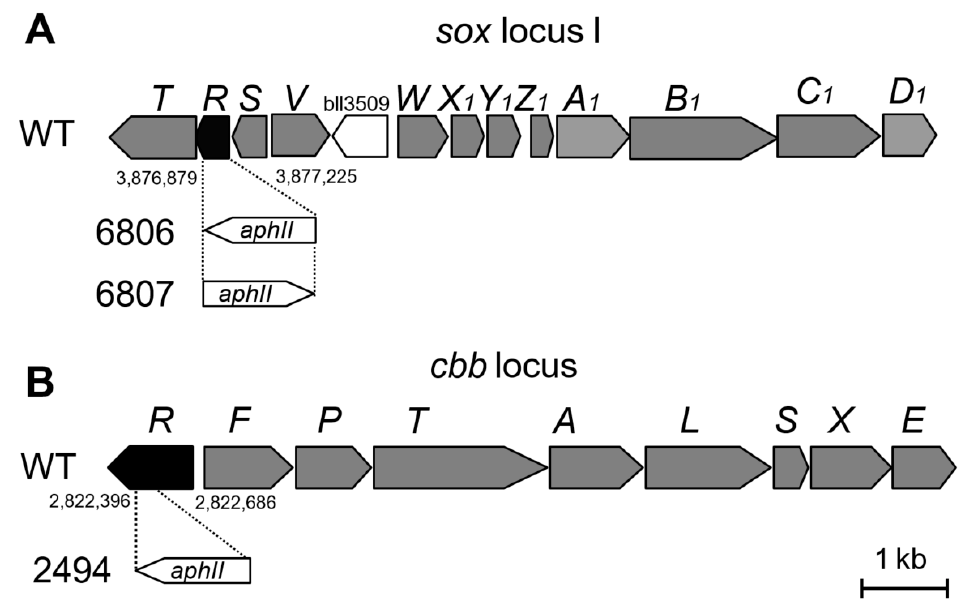
Figure 1. Genetic maps of the sox and cbb gene clusters in B. diazoefficiens . ( A ) Genes of sox locus I in the wild type, and the genotype of soxR deletion mutants 6806 ( ∆ soxR , same orientation of the aphII gene) and 6807 ( ∆ soxR , aphII in opposite orientation). The ∆ soxR deletion ends are defined by the nucleotide positions in the B. diazoefficiens genome. ( B ) Genes of the cbb cluster in the wild type, and the genotype of cbbR mutant 2494. The ∆ cbbR deletion ends are defined by the nucleotide positions in the genome.